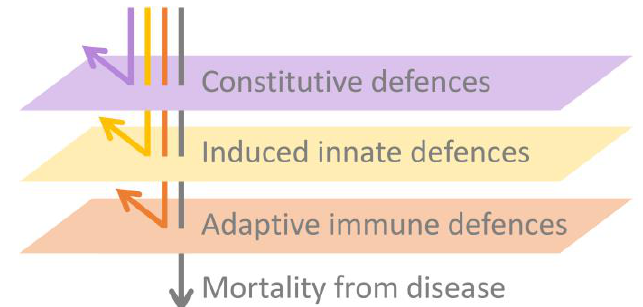
Figure 3. Schematic depicting the layered nature of the immune responses to infection in simplified